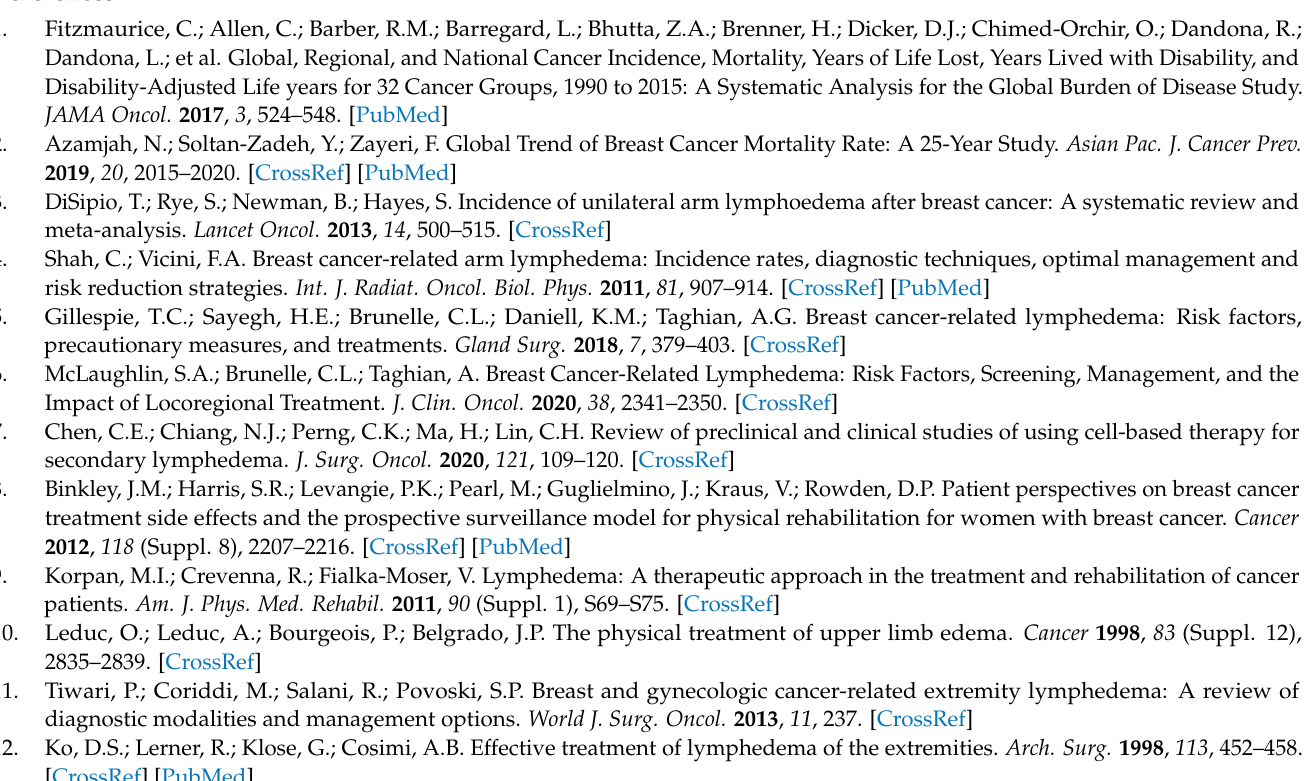
Scale Score; Table S4: Studies and methodological quality description according to the Modified Jadad Scale with eight items; Table S5: Summary of quality assessment (using STROBE assessment tools) of the included articles; Table S6: Appraisal of included studies, using the GRADE tool; Table S7: Skin thickness difference measurement of included studies; Table S8: ROM measurement of included studies; Table S9: Arm circumference measurement of included studies; Table S10: qDASH measurement of included